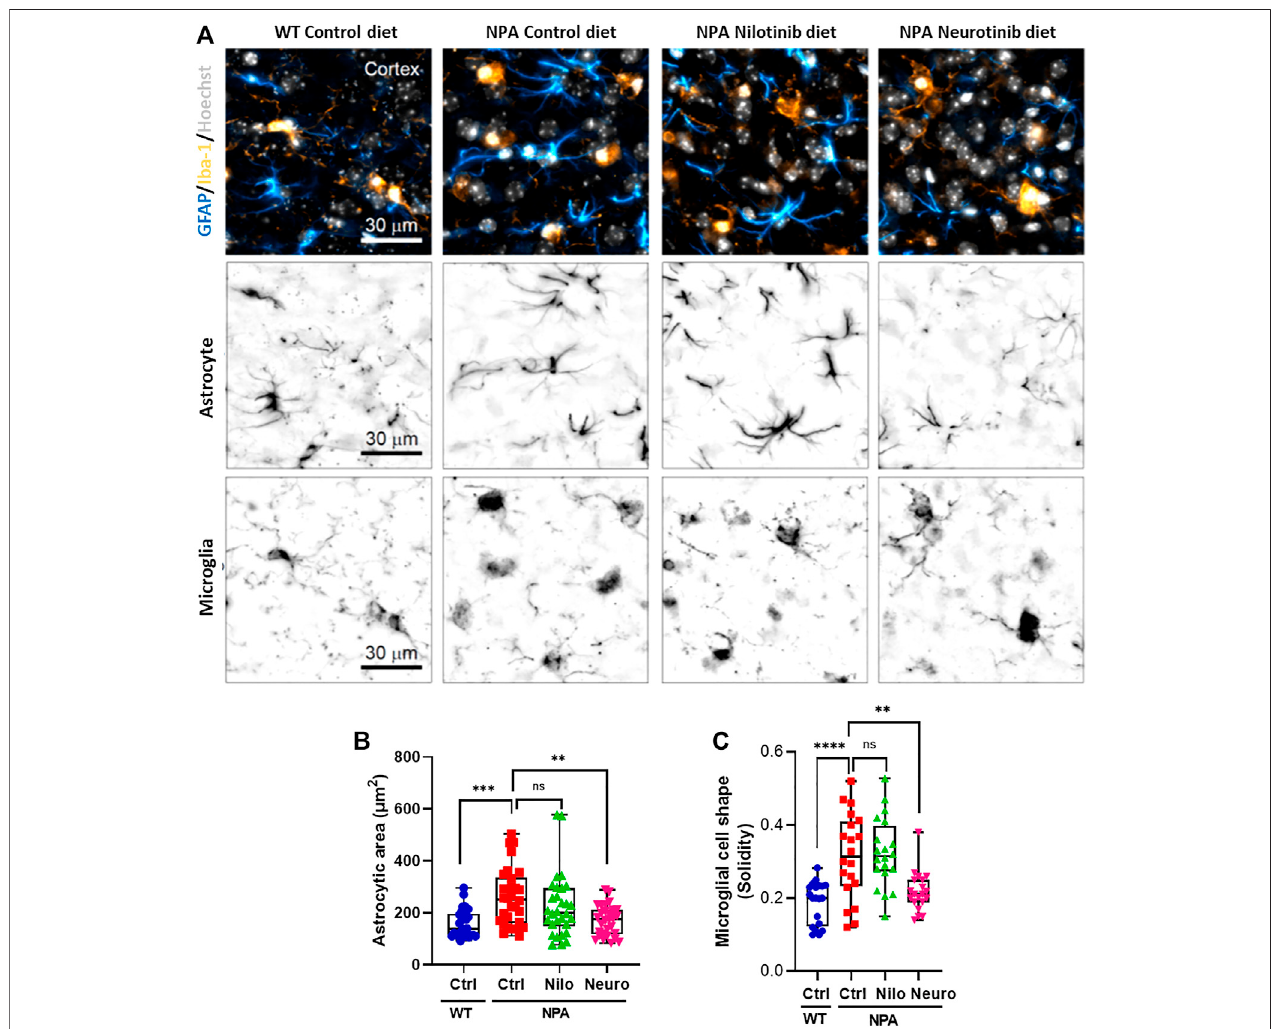
FIGURE 6 | Chronic c-Abl inhibition decreases glial activation in NPA mice. WT and NPA mice received nilotinib (200 ppm; 30 mg/kg) and neurotinib (67 ppm; 10 mg/kg) supplemented diets or control diet starting at p21 until 7 months of age. (A) Markers of astrocyte (GFAP) and microglia (Iba-1) were analyzed by immuno fl uorescence in slices of brain from WT and NPA mice. Confocal images were obtained of the cortex for each condition. A representative image of the cortex is shown in the fi rst row; astrocytes (cyan hot), microglia (orange hot), and nucleus (grays). Representative images to visualize astrocyte and microglial shape are shown in the second and third row, respectively. (B) Astrocyte area was measured from GFAP positive cells. For each condition, n = 10 cells were measured by animal; three mice/group. ANOVA, Tukey post-hoc : ** p < 0.01, *** p < 0.001. (C) Microglia shape was determined from Iba-1 fl uorescence. For each condition, n = 5 – 10 cells were measured by animal; three mice/group. ANOVA, Tukey post-hoc : ** p < 0.01, **** p < 0.0001. In the box-and-whisker plots, the center line denotes the median value, edges are upper and lower quartiles and whiskers show minimum and maximum values.